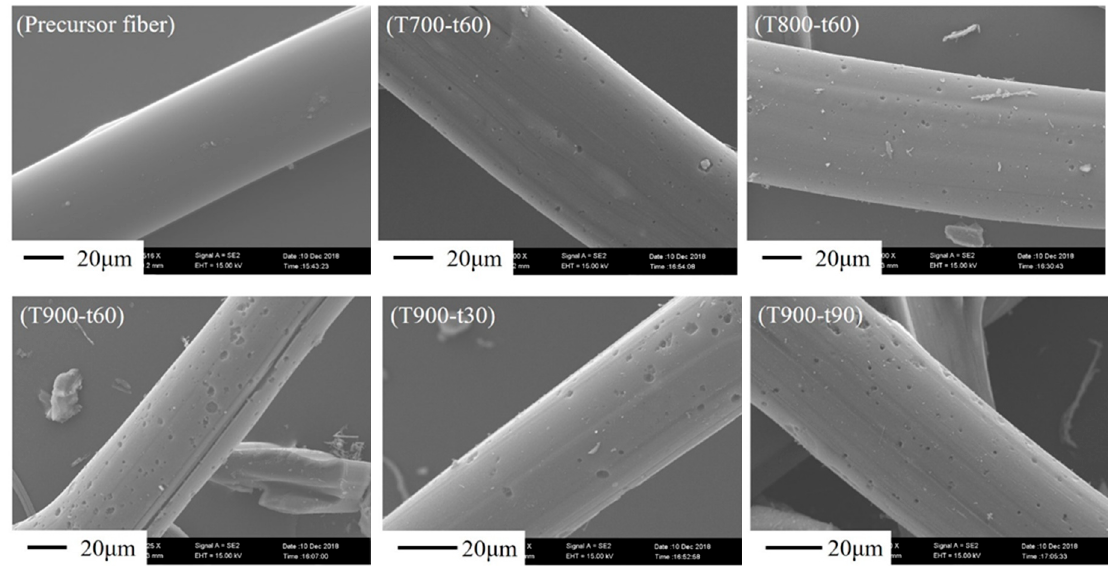
Figure 4. SEM micrographs of ACFs as a function of activation temperature and time.